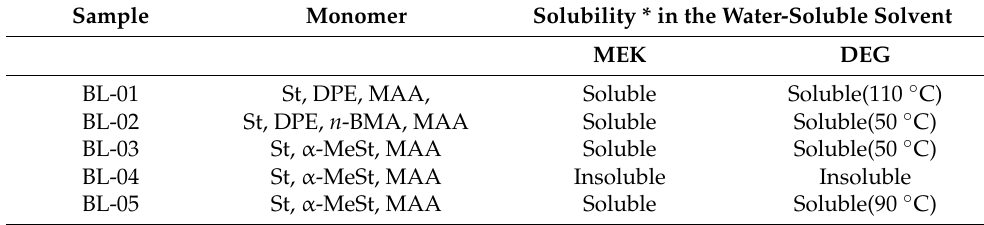
Table 3. Polymer solubility in